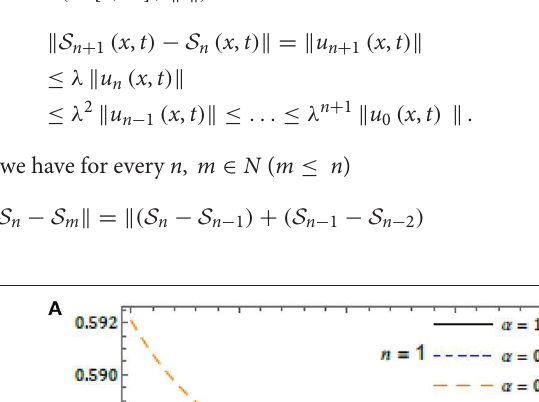
Frontiers in Physics |